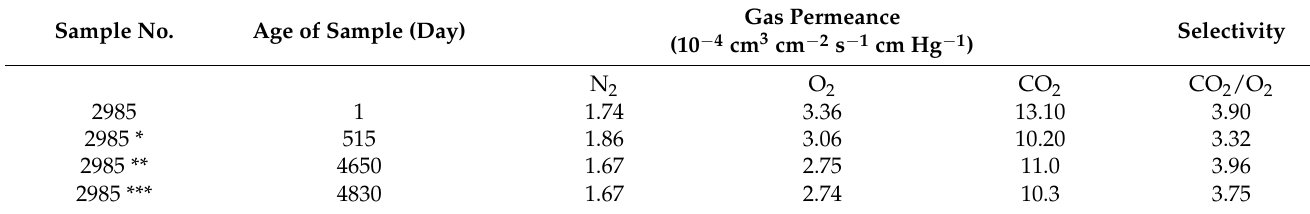
Table 12. Changes in the gas permeability characteristics of TMDSO polymer-coated X30-240 HFM on